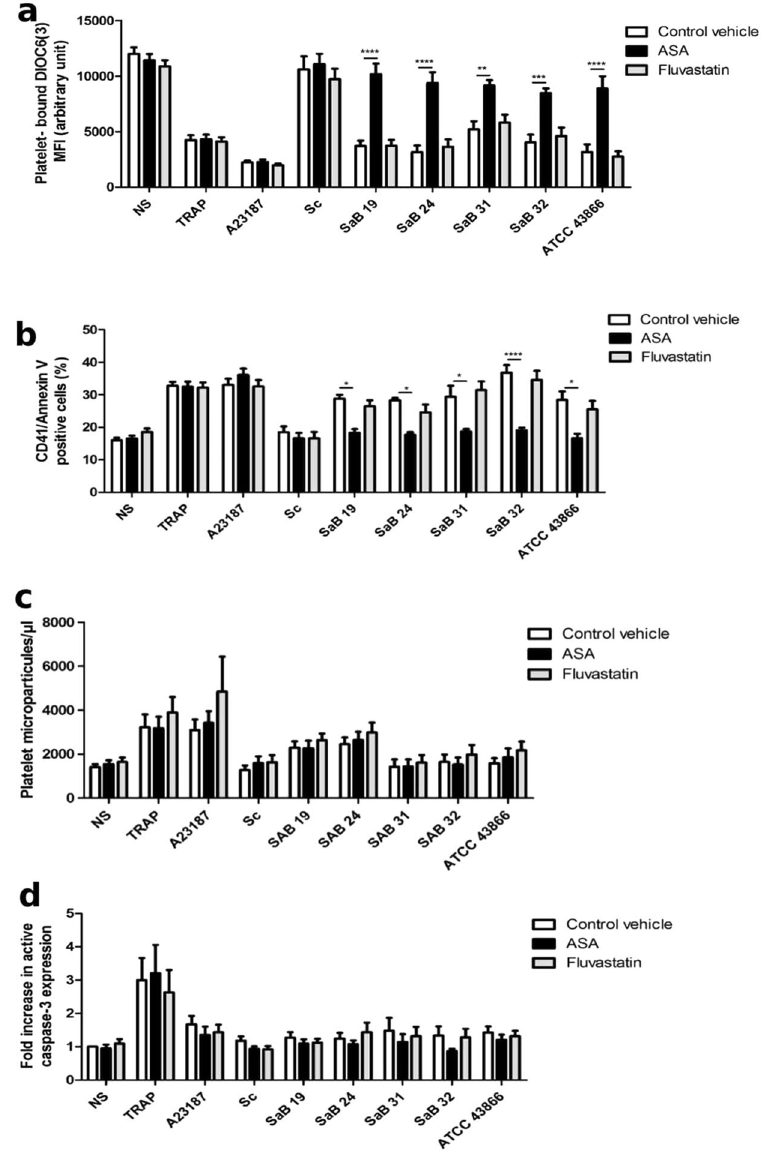
Figure 8. Effect of ASA and fluvastatin on S. aureus -induced platelet cell death. ( a ) The MFI of platelet-bound DIOC6(3) ( b ) Annexin V binding ( c ) PMP concentration or ( d ) fold increase in active caspase-3 expression were analyzed by flow cytometry after 30 min of exposure to Tyrode’s buffer (as a negative control, NS), TRAP, staphylococcal strains [clinical strains (SaB), S. condimenti (Sc) or S. aureus ATCC 43866 (ATCC43866)] or the A23187 apoptosis inducer ( as a positive control), with ASA, fluvastatin or water (as a control vehicle). ( a ) The data (mean ± SEM; n = 8) are expressed as AU. (b) The data (mean ± SEM; n = 8) are expressed as the % expression ( c ) The data (mean ± SEM; n = 9–27 experiments) are expressed as microparticles/ µ l. The data (mean ± SEM; n = 6–15 experiments) are expressed as the fold increase in active caspase-3 expression. ** p < 0.01; *** p < 0.001, **** p < 0.0001 (two-way ANOVA with repeated measures and the Bonferroni post hoc test; ASA or fluvastatin vs . control